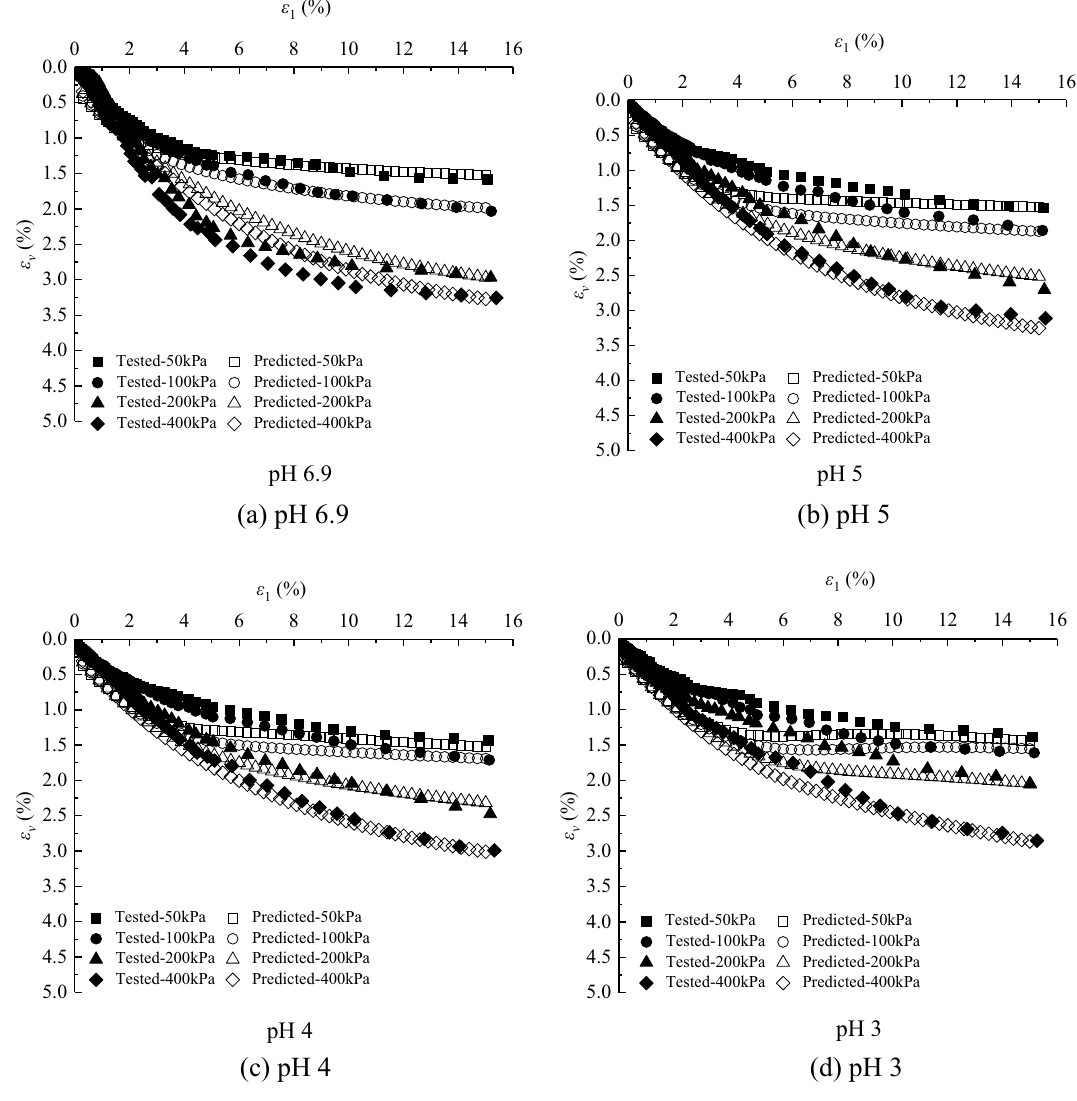
Figure 10. Volumetric strain–axial strain for tests and